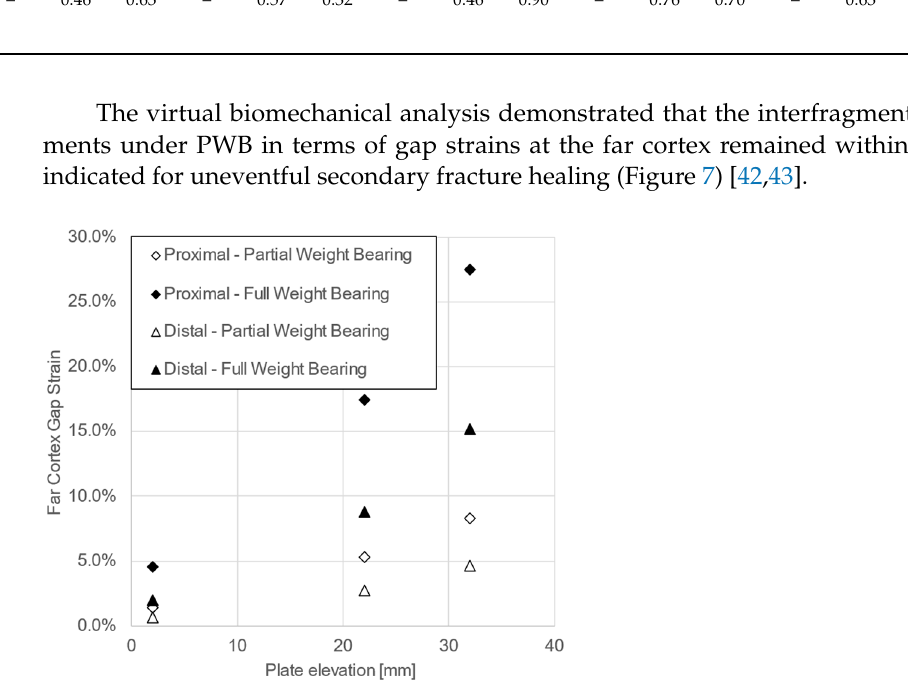
Figure 7. Gap strain at the far cortex as predicted by the FE models of the unstable meta-diaphyseal proximal and distal tibial fractures, mimicked via osteotomizing a 20 mm gap and fixed with three different plate elevations of 2 mm, 22 mm, and 32 mm for partial and full weight bearing scenarios of 250 N and 800 N, respectively.